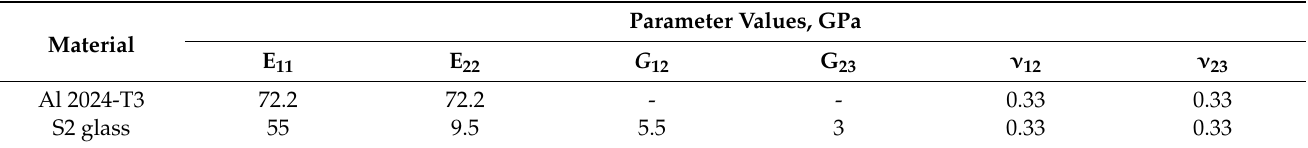
Table 1. Material properties used in the finite element model [4,5].